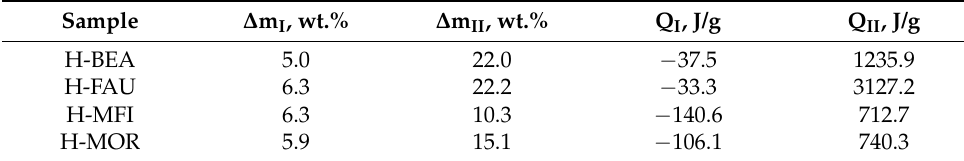
Table 3. Weight changing and normalized thermal effects of spend samples (2 h, 150 ◦ C).